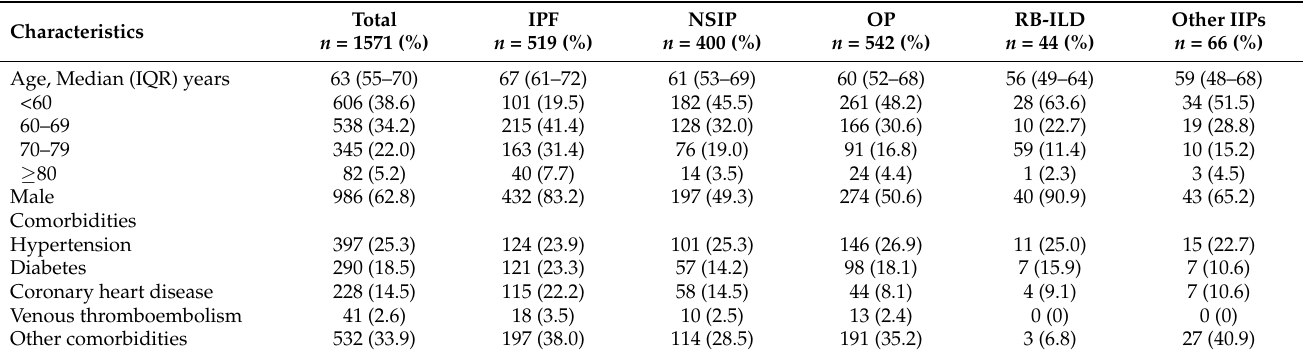
Table 2. Demographic characteristics of IIP.